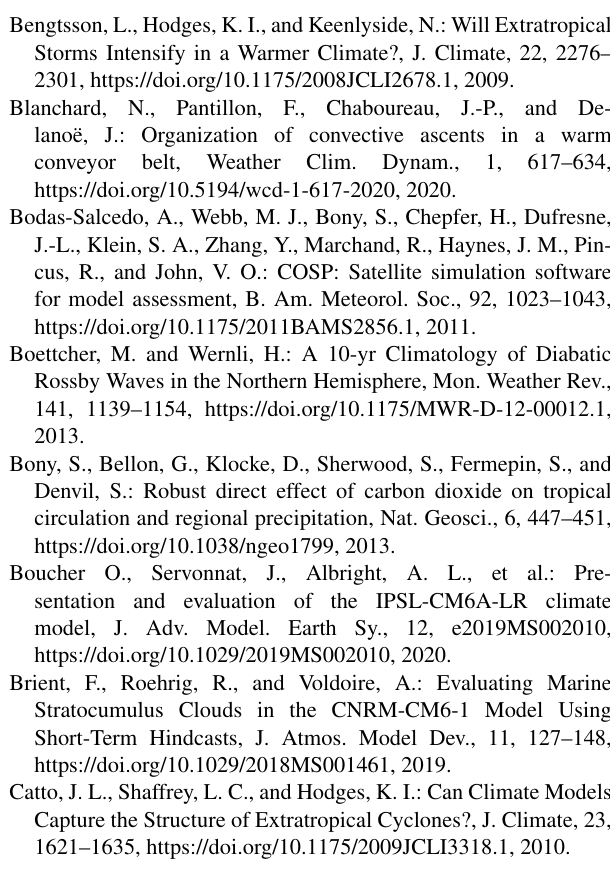
Figs. 1–9 and S1–S4 in this paper. Ferret is a product of NOAA’s Pacific Marine Environmental Laboratory (information is